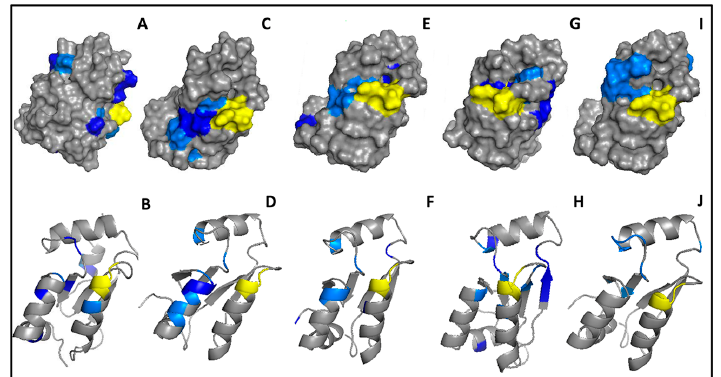
Figure 5. Comparison of binding pockets defined by compounds based on CSPs for BrmGRX and hGRX1. Surface and secondary structures for: ( A , B ) RK207 vs. hGRX1, defining multiple possible binding sites; ( C , D ) RK207 vs. BrmGRX, having binding pockets near to the conserved CPYS active site; ( E , F ) RK207ACPacid [ 6 ] vs BrmGRX; ( G , H ) RK207ACPester [ 5 ] vs. BrmGRX; ( I , J ) Acrylamide vs. BrmGRX, respectively (Patches: yellow-CPYC active site; light blue—residues with CSPs exceeding the standard deviation; dark blue—residues exceeding 2 × the standard deviation).